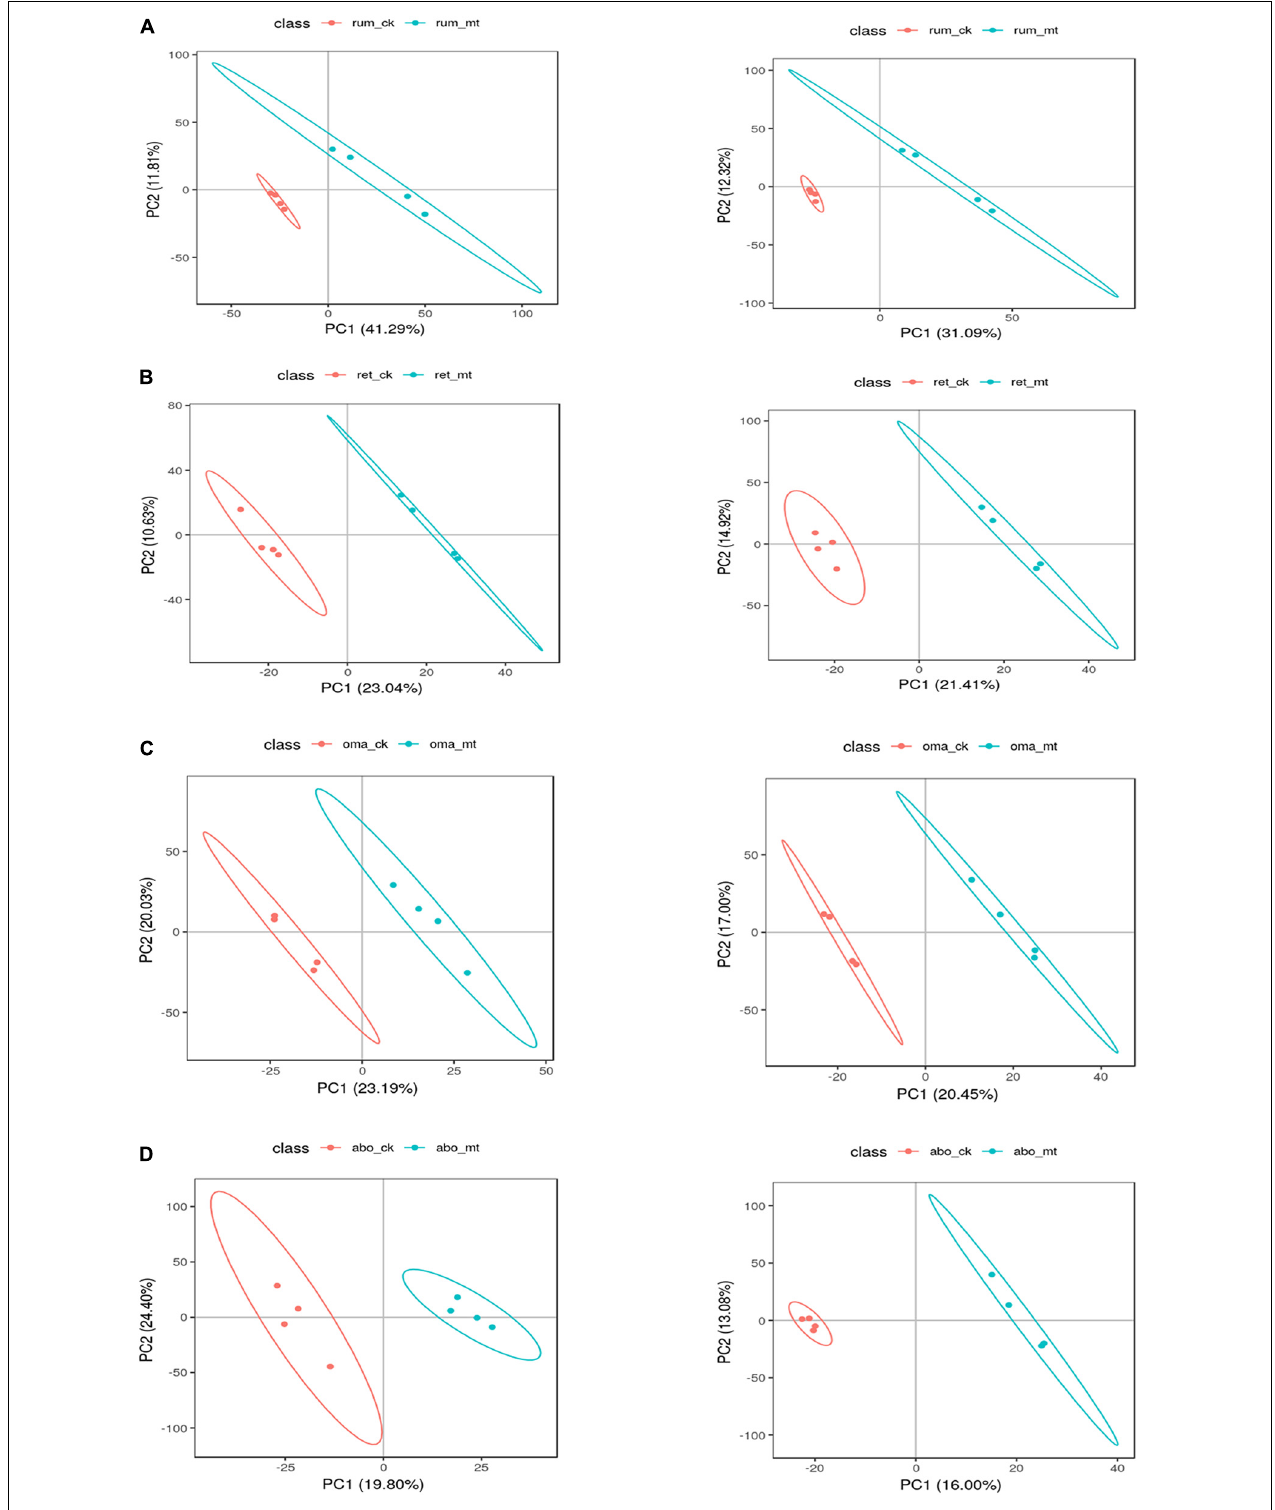
FIGURE 3 | Differential metabolites analysis of the stomach between the MSTN + / − and WT cattle. PLS-DA plot of fecal metabolites detected in negative (left) and positive (right) mode of MSTN + / − and WT cattle in the rumen (A) , reticulum (B) , omasum (C) , and abomasum (D) .